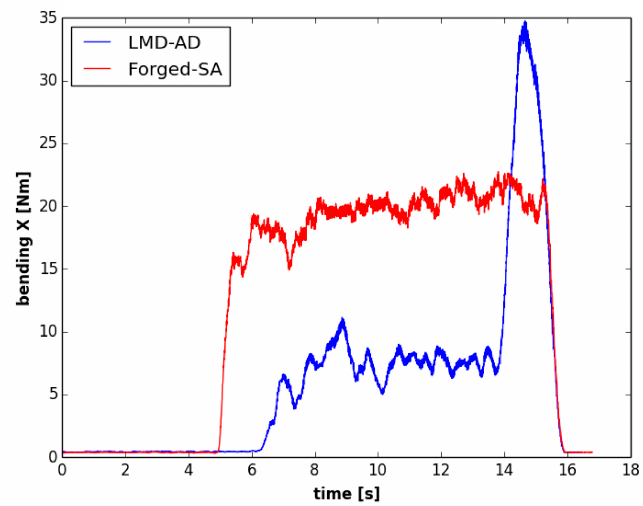
Figure 12. Bending moment evolution over time for face 1 in the first set of experiments (first pass).